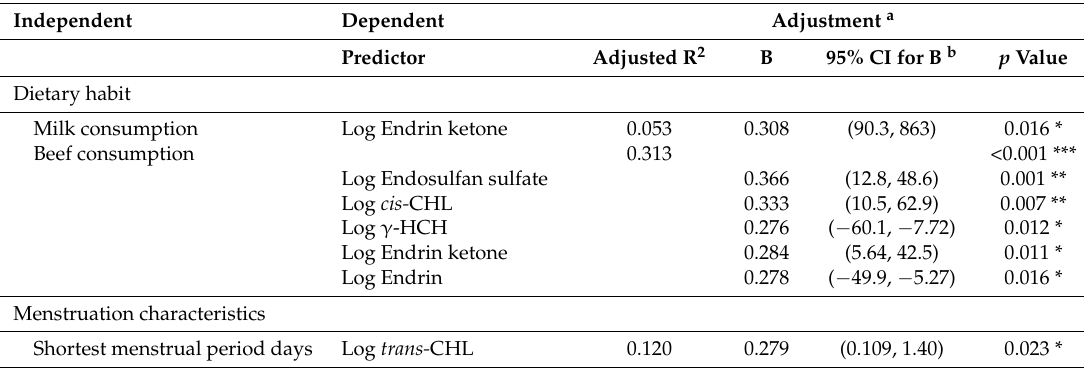
Table 4. Significant associations between milk OCPs and dietary habit and menstruation characteristics using a stepwise linear regression.